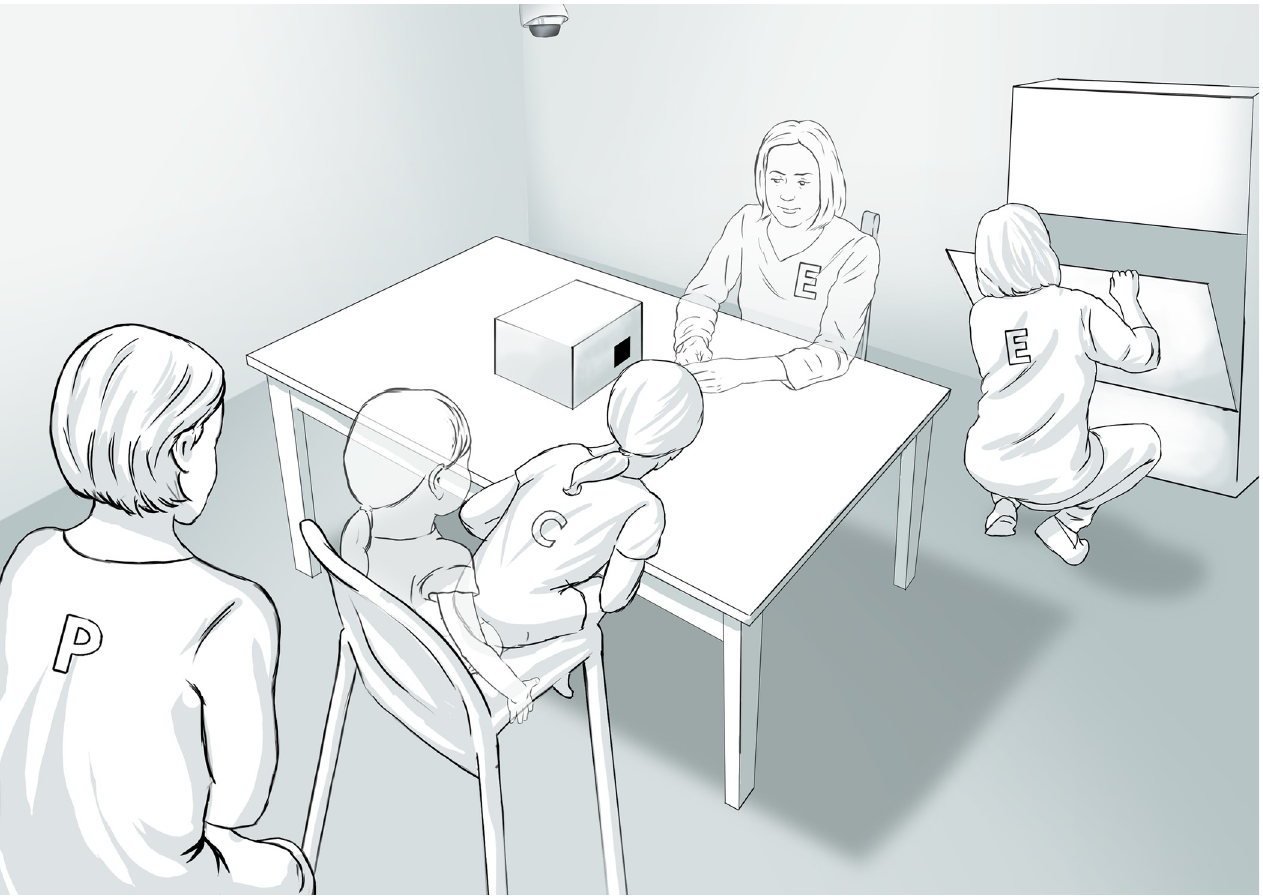
Fig 1. Modified temptation resistance paradigm. Fading figures of a child and a researcher present their position before the prohibition